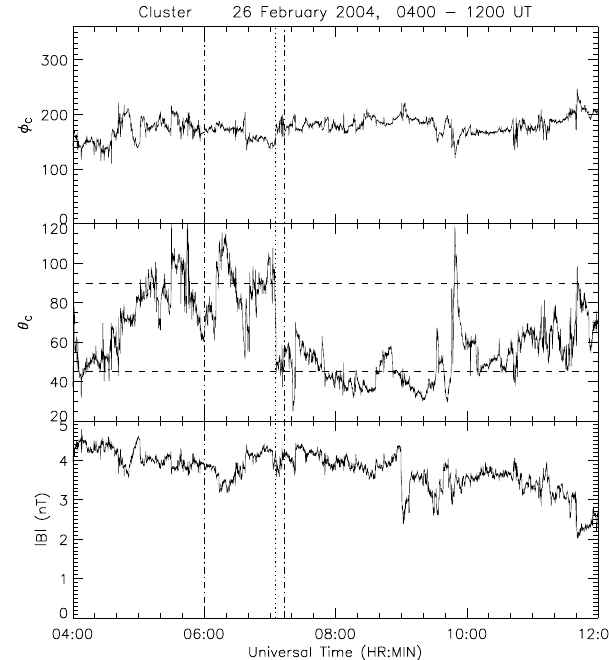
Fig. 4. The clock angle ( φ c , top panel), cone angle ( θ c , middle panel) and magnitude | B | (bottom panel) of the IMF measured by